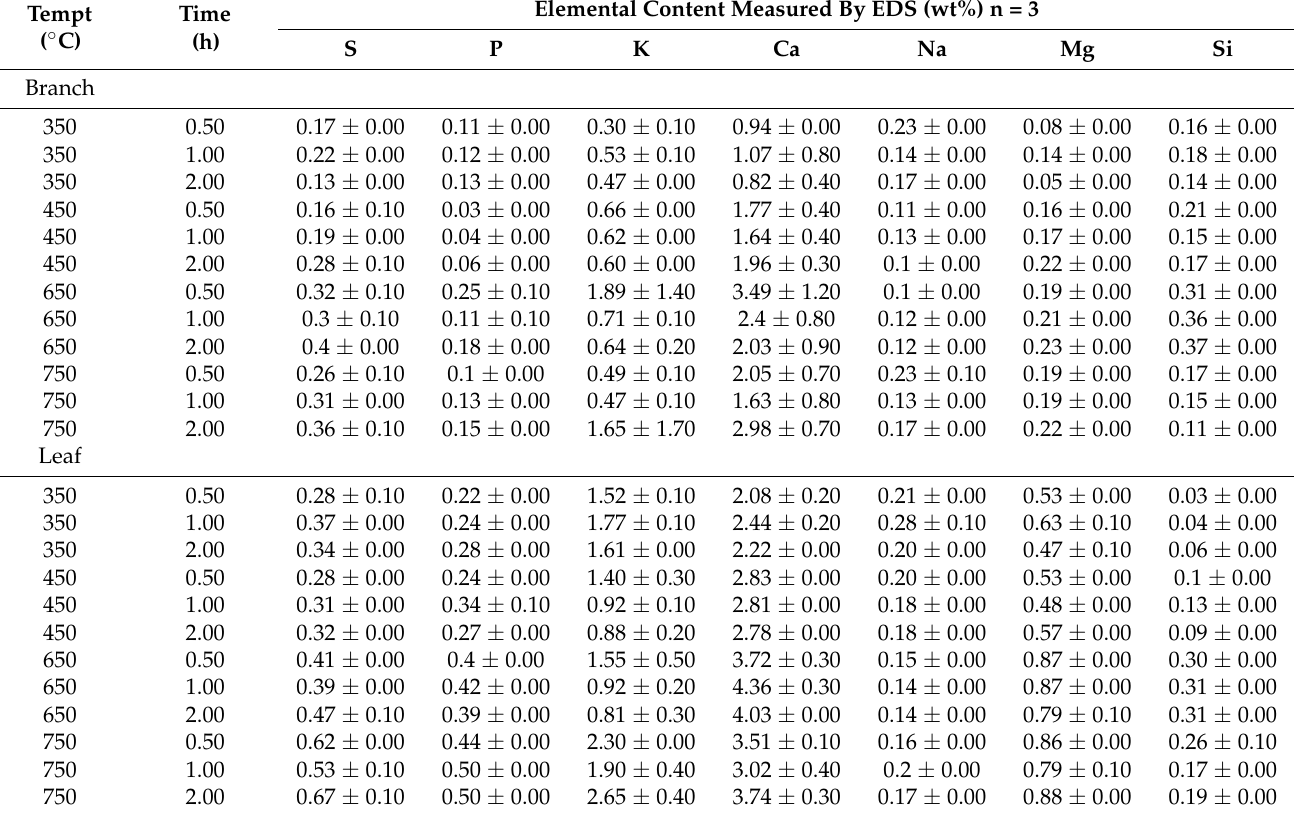
Table 4. Elemental composition on biochar surface.